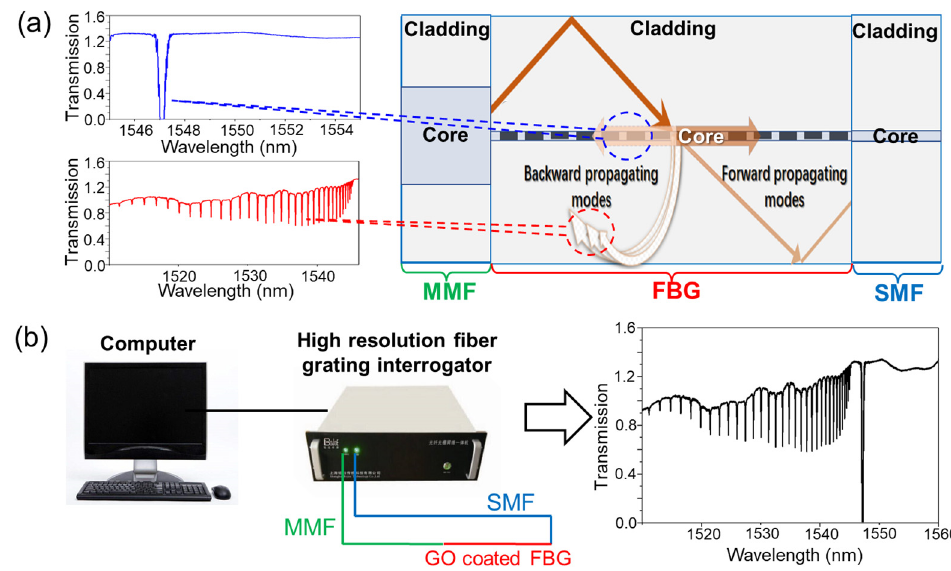
Figure 1. Illustrations of the sensing element ( a ) and the sensing system ( b ) of the FBG sensor based on cladding mode resonance.